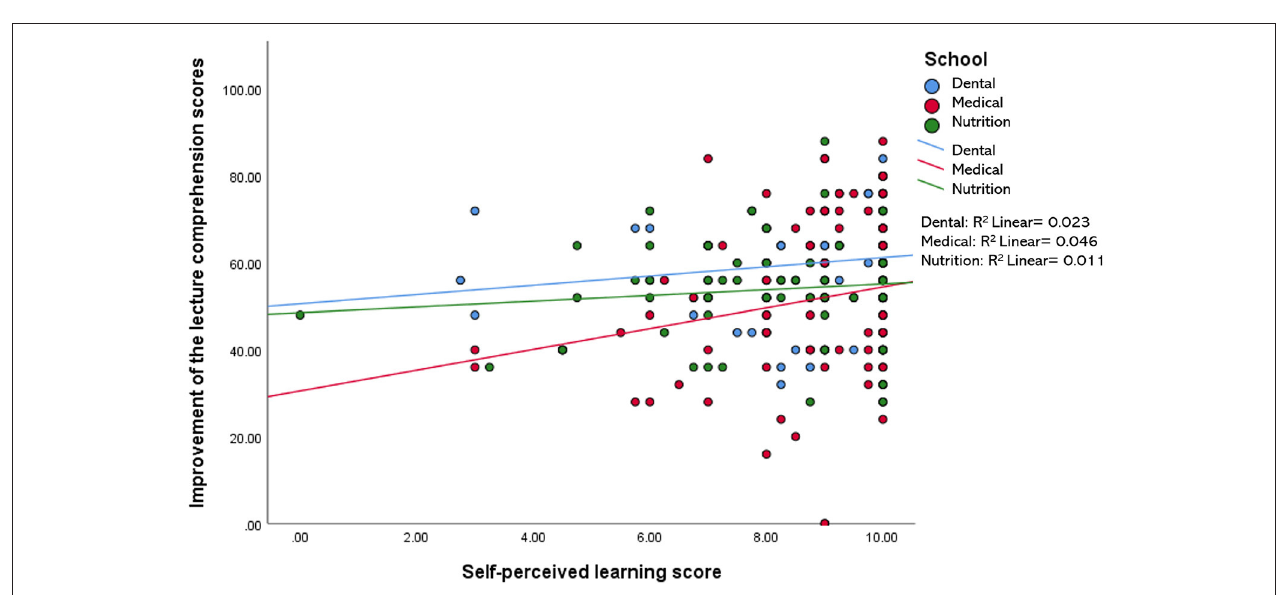
FIGURE 4 | Improvement of the lecture comprehension scores vs. the self-perceived learning score after the CLT-based online